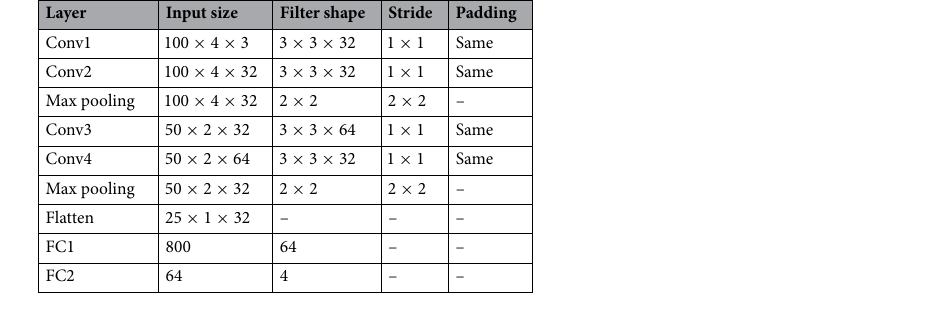
Table 3. Network architecture of the optimal AutoKeras model (window size: 50).